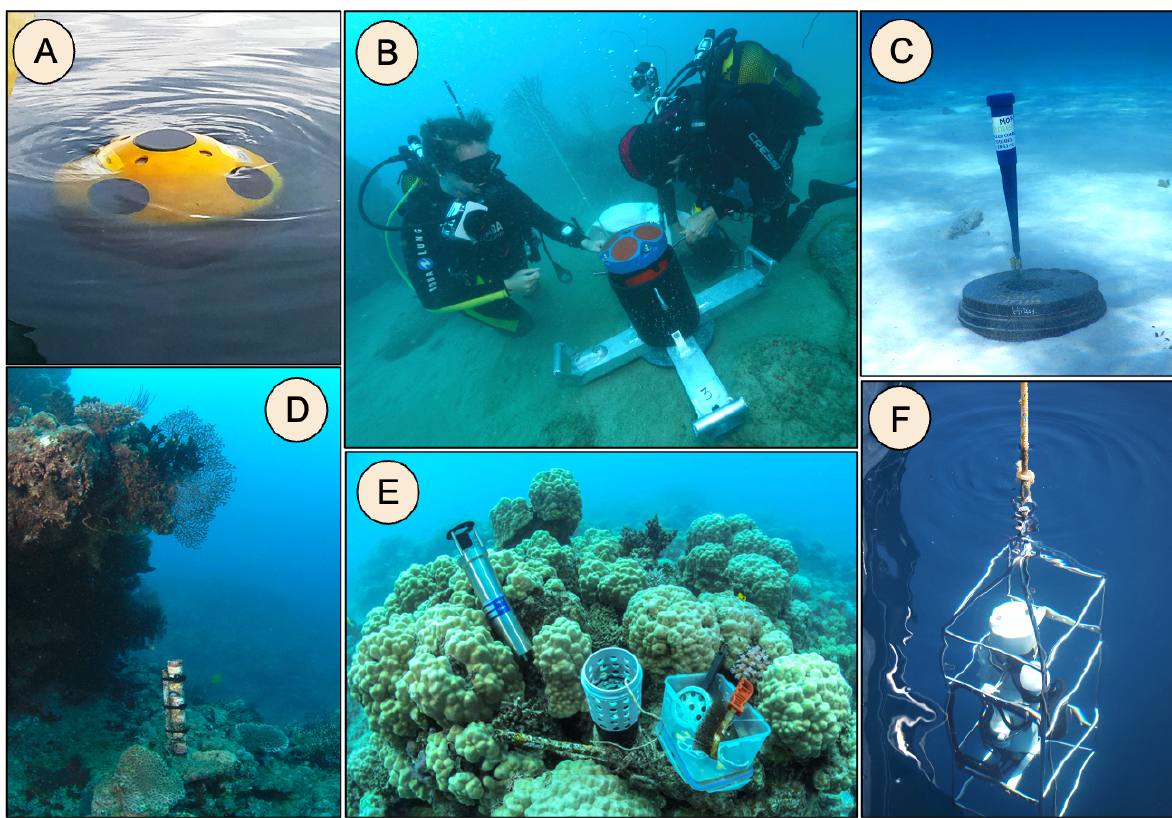
Figure 4. Photographs of deployed instruments for the PRESENCE project. (a) Reef drifter, (b) acoustic doppler currents profilers, (c) Cur- rent meter Marotte HS, (d) RBRduet T.D, (e) maintenance of a JFE Advantech logger, and (f) CTD SBE 19plus profiler. Photo credit: IFREMER LEAD-NC; US